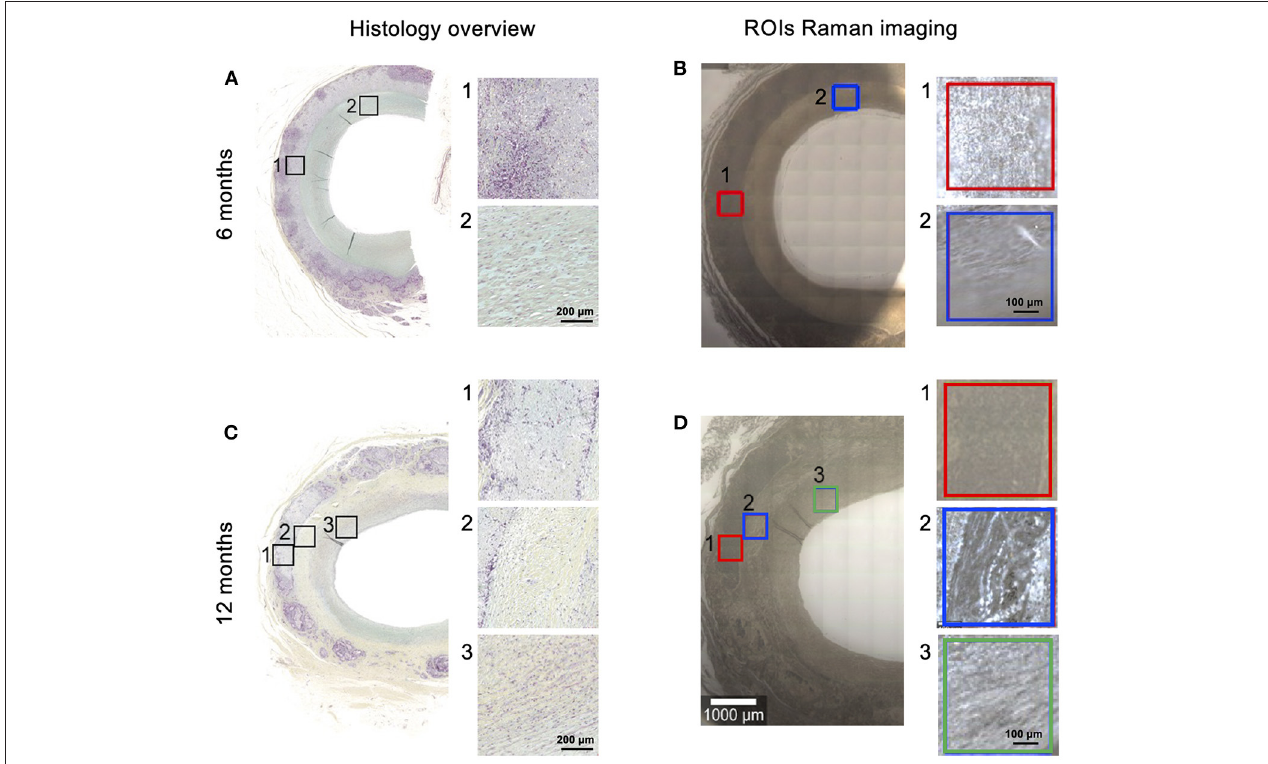
FIGURE 1 | Overview of analyzed scaffolds and regions of interest (ROIs). PC-UPy scaffolds were implanted in a sheep model. FFPE sections of 6-month (A,B) and 12-month (C,D) explants were analyzed. ROIs for Raman imaging (B,D) were defined in Movat-Pentachrome stained sections (A,C) (provided by CVPath). In 6-month samples scaffold material (1) and lumen (2) were distinguished, in 12-month samples scaffold material (1), material-tissue interface (2) and neointimal lumen (3) were defined as